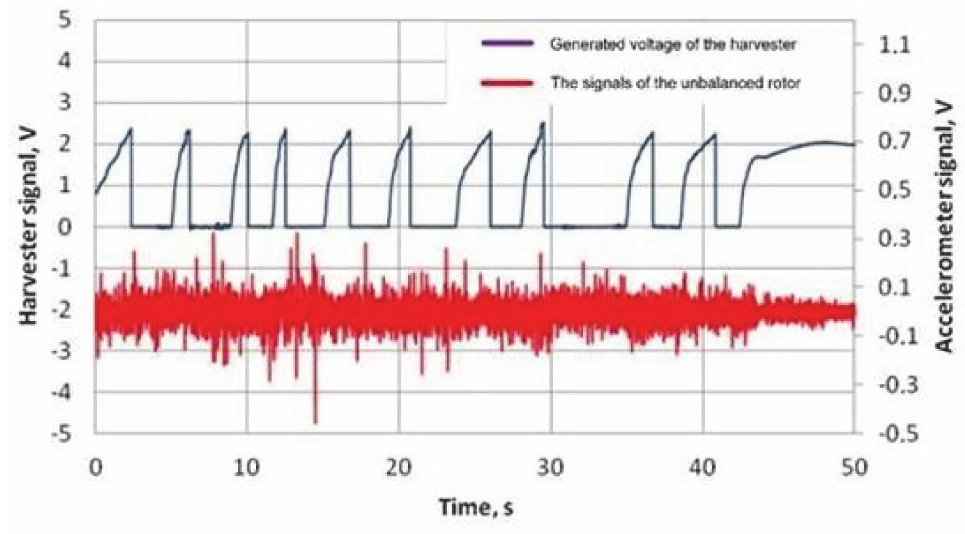
Figure 21. Generated voltage of the harvester (upper blue color) and the signals of the unbalanced rotor (lower red color); the time of capacitor charge until 2 V was ~2–3